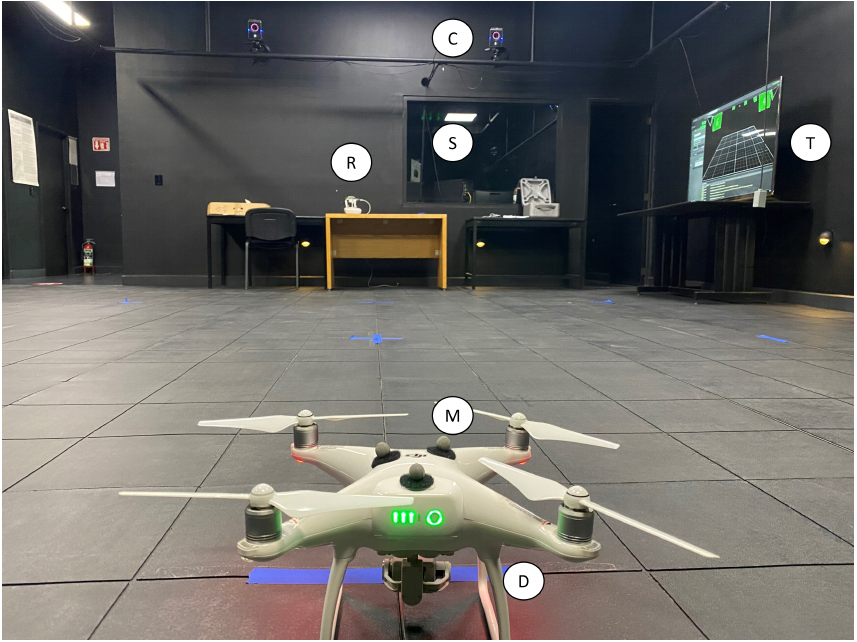
Figure 4. Components of the UAV-based smart educational mechatronics system: drone (D), markers (M), remote control (R), server computer (S), camera (C), and TV monitor